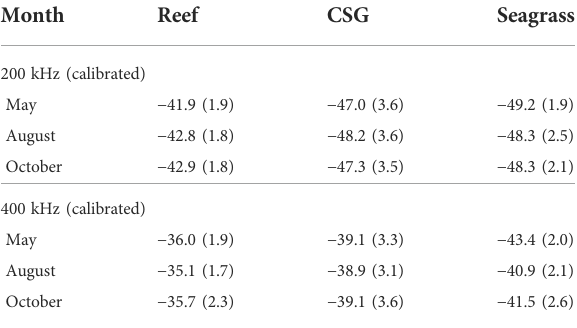
TABLE 3 Average backscatter (standard deviation)